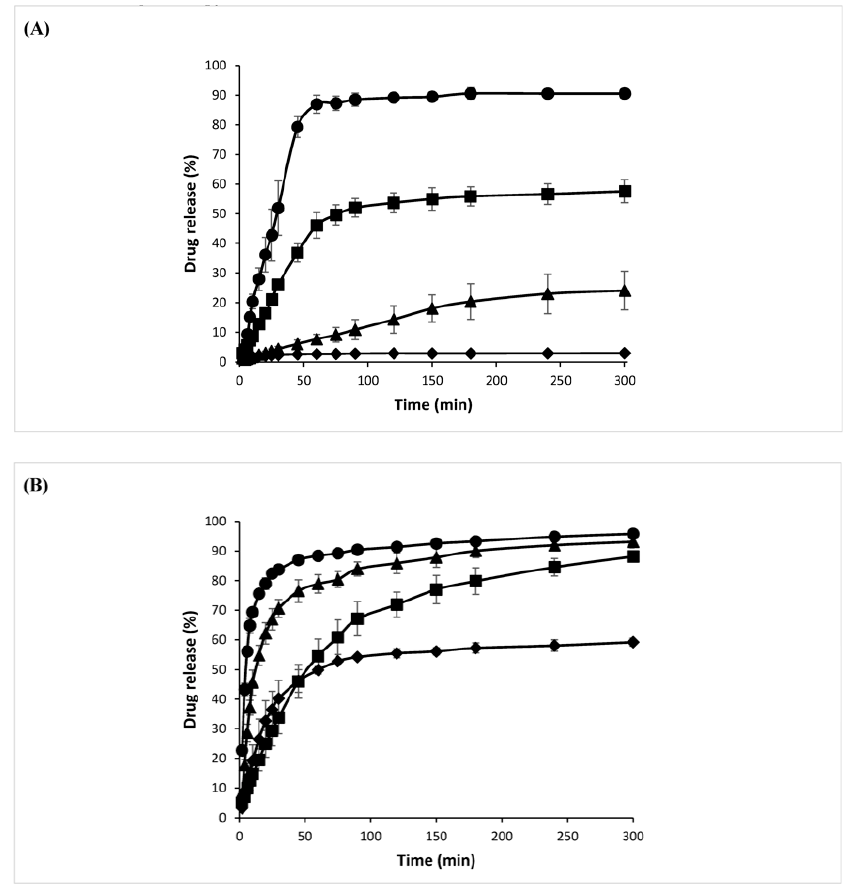
Figure 9. Drug release profiles of spray-congealed microparticles containing 20% w / w paracetamol for PW59:SA ( ); PW59:CA ( (cid:4) ); PW59:CE ( (cid:78) ); PW59 ( (cid:7) ) in the ( A ) absence and ( B ) presence of 0.05% w / v sodium lauryl sulphate ( n = 3).